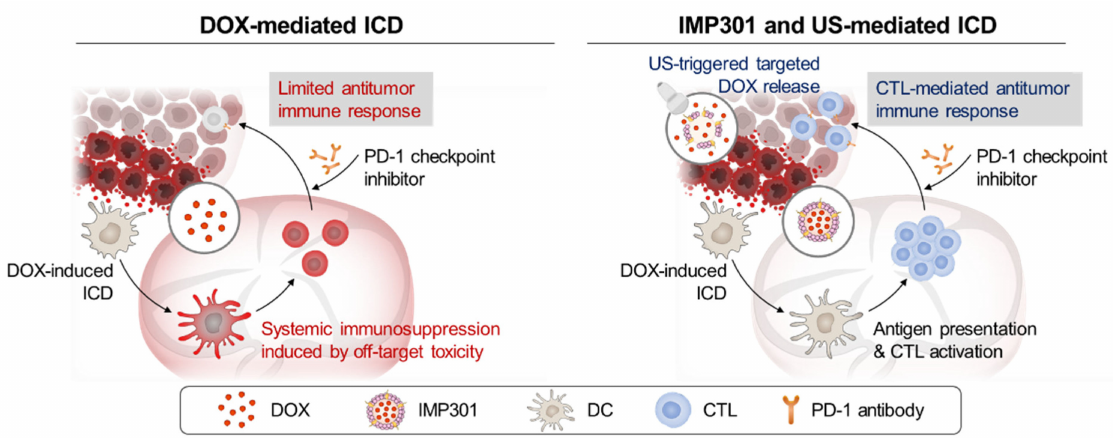
Figure 1. Schematic illustration of DOX-mediated ICD and IMP301 and US-mediated